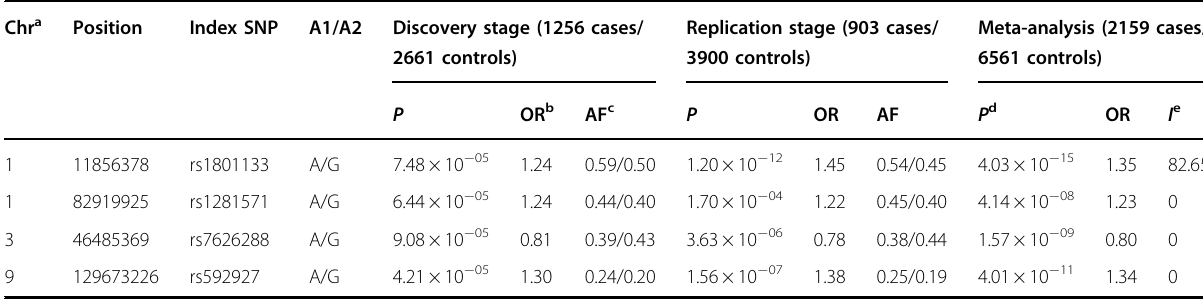
Table 1 Genome-wide signi fi cant loci identi fi ed in this study. Chr